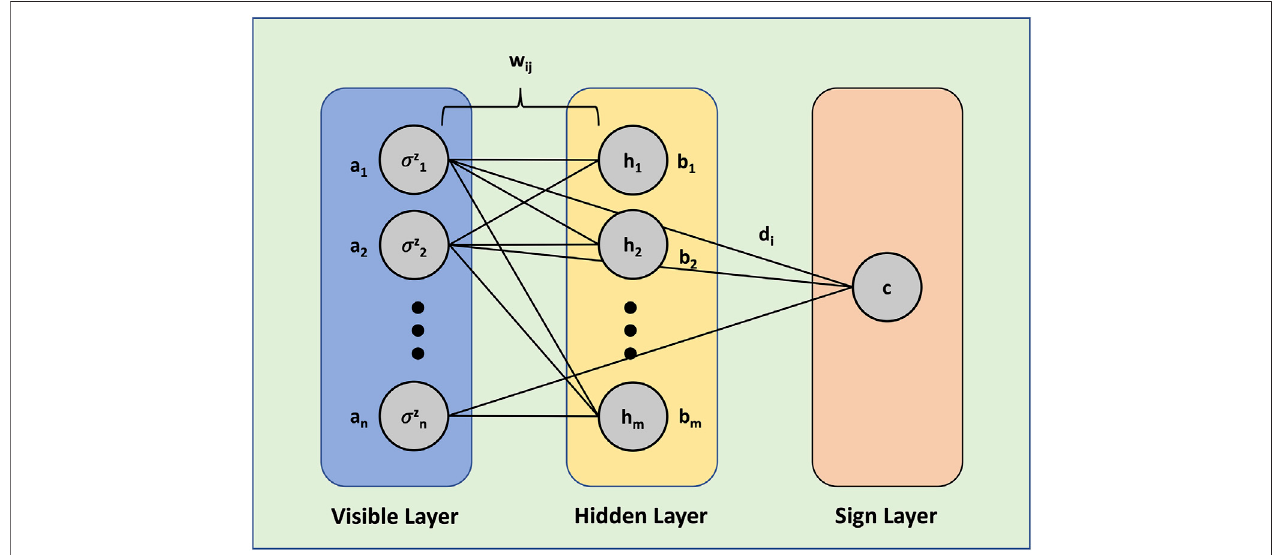
FIGURE 2 | Restricted Boltzmann Machine architecture. The fi rst layer is the visible layer with bias parameters denoted by a i . The second layer is the hidden layer withbiasparametersdenoted by b j .The thirdlayer isthesignlayerwith biasparameters denoted by c . Theweights associated withthe connections betweenthe visible neurons and the hidden neurons are designated by w ij . The weights associated with the connections between the visible neurons and the neuron of the sign layer are designated by d i .